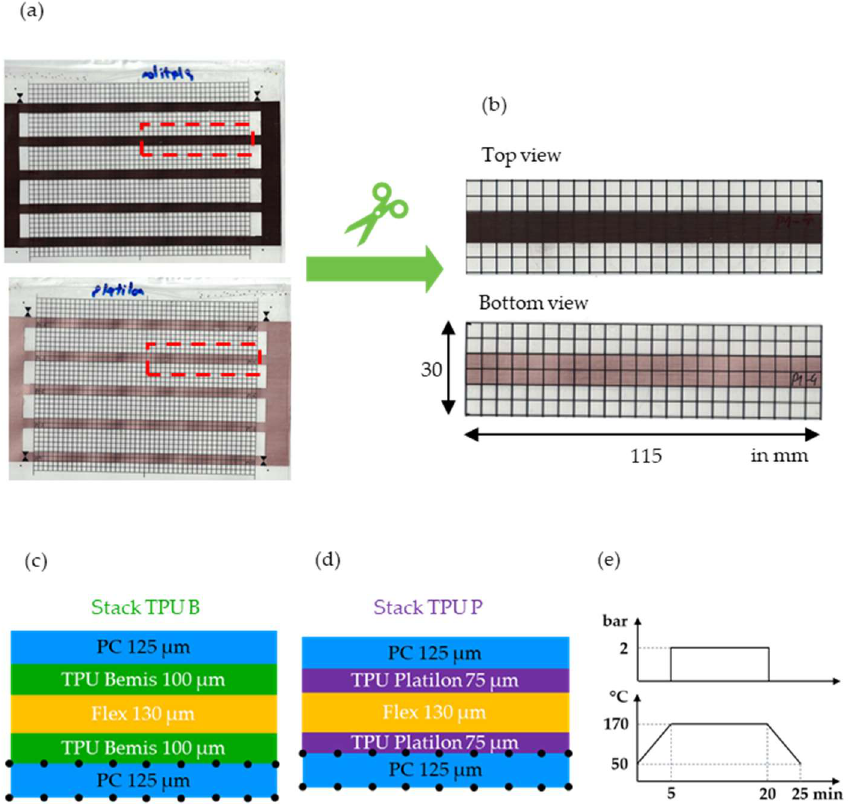
Figure 2. The individual sheets were laminated together ( a ) and cut into the film strips ( b ) for overmolding. The two used layer structures are shown in ( c , d ), respectively, and the lamination parameters are indicated by ( e ).